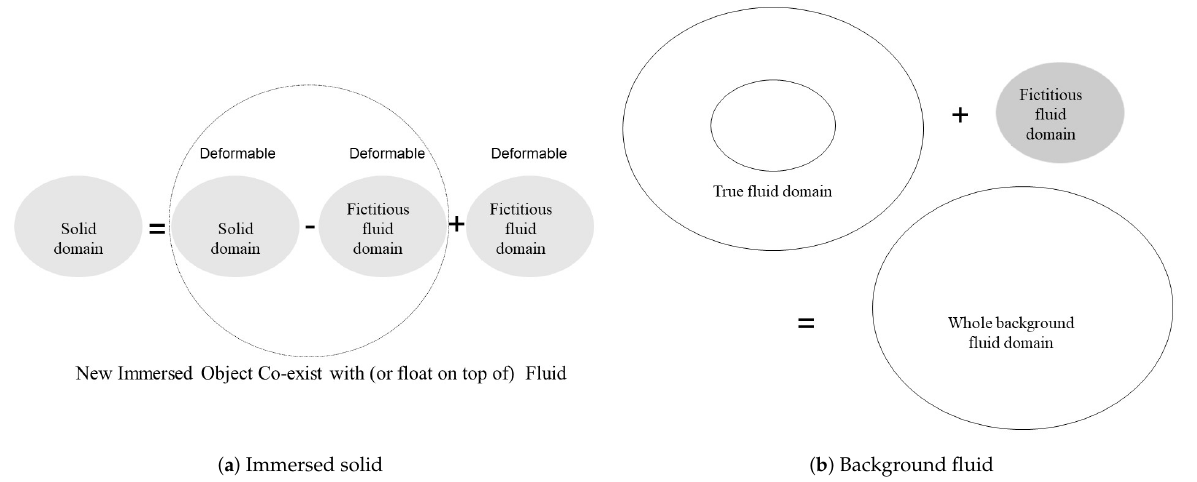
Figure 2. An illustration of a Lagrangian mesh on top of a Eulerian mesh for immersed